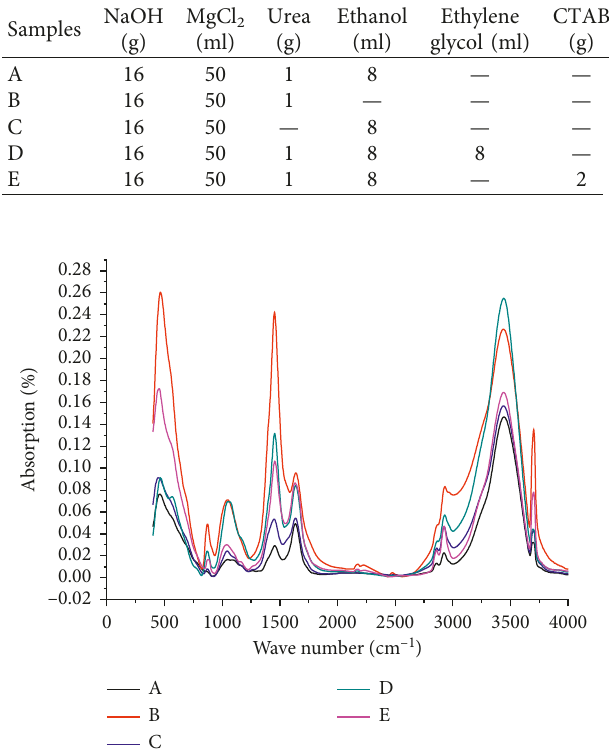
Figure 1: FTIR of prepared